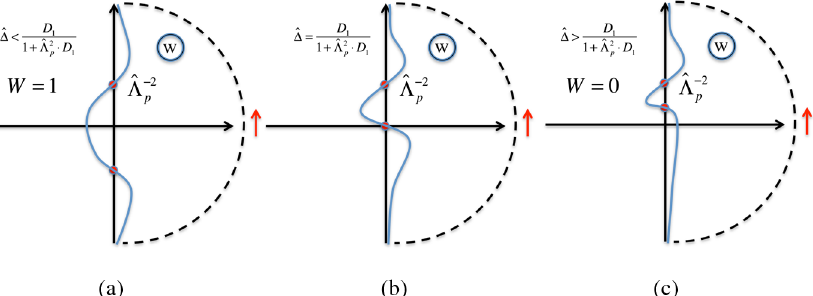
FIG. 3. Schematic drawing of possible D mapping when ^ F ð ^ P Þ has only one extrema. (a) Low or negative detuning yields a winding 1 number of 1, i.e., one growing mode. Part (b) corresponds to the cutoff frequency for FEL instability. (c) Above the threshold the winding number is 0, i.e., there are no growing